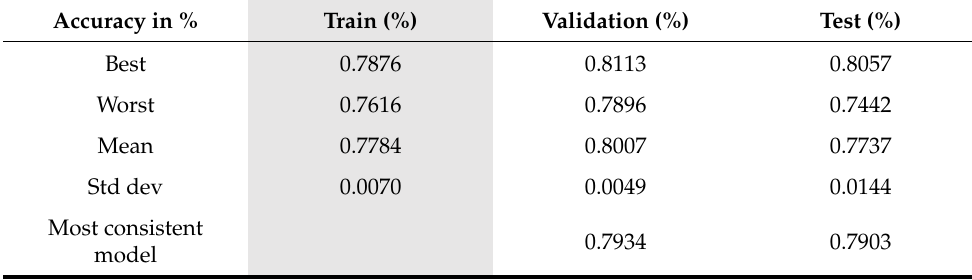
Table 1. Summary table for Approach A1—Greedy accuracy (in %).